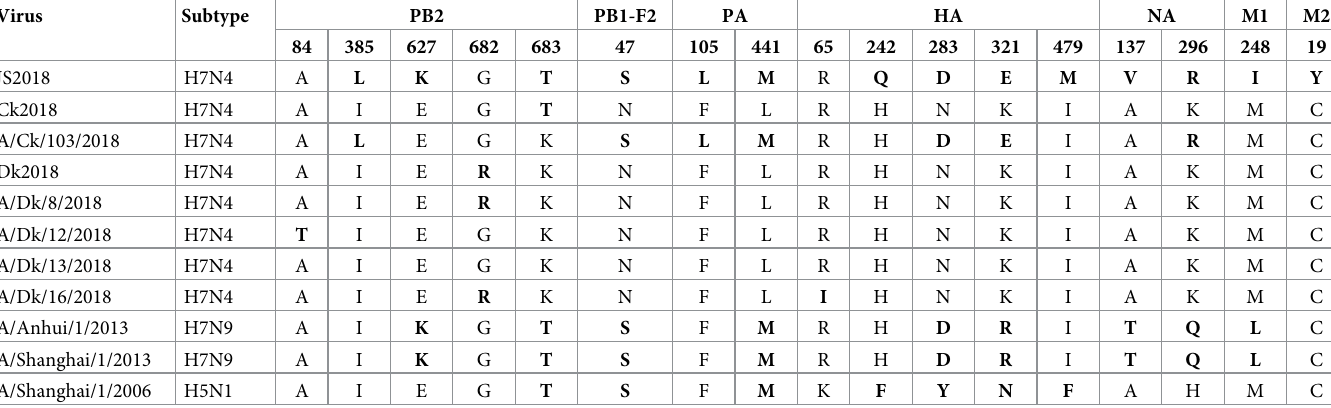
Table 2. Whole-genome mutations in the human H7N4 isolate compared with related H7N4 avian isolates and human H7N9 and H5N1 isolates.